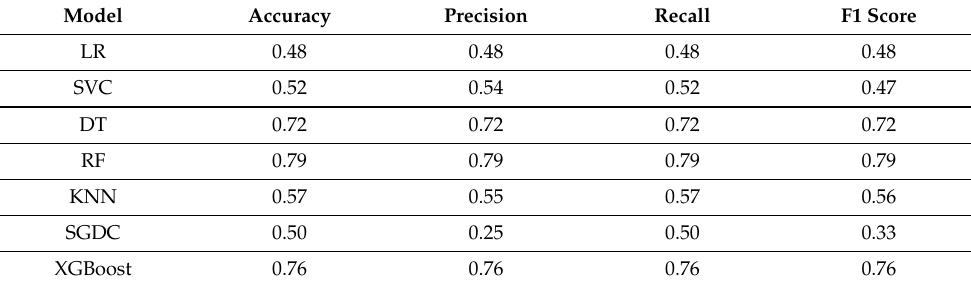
Table 4. Results of models obtainedby deleting missing values from the dataset.